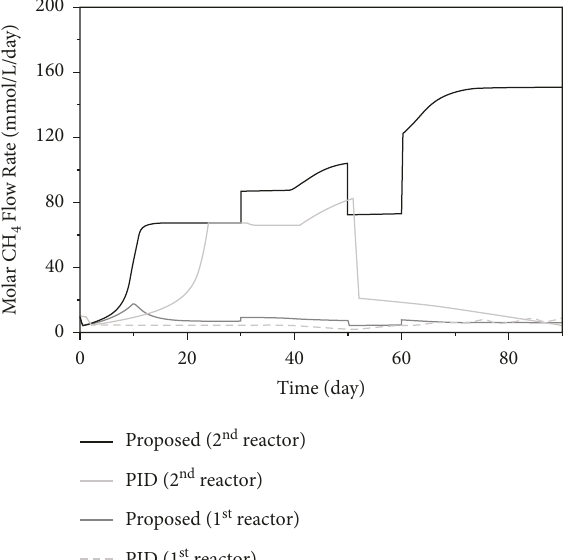
Figure 12: The responses of methane production rate under the condition with changes in the bacterial maximum growth rate and inlet COD